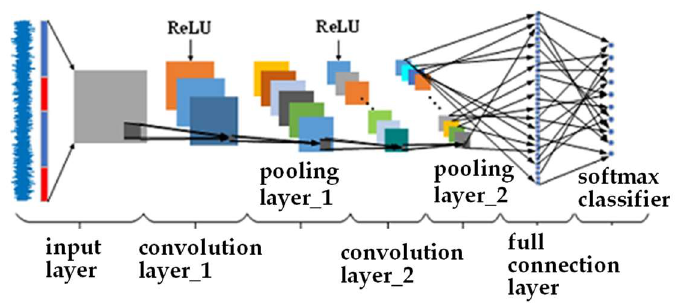
Figure 1. two-dimensional convolutional neural network model. The specific parameters of the TDCNN structure are shown in Table 1. The initial learning rate is 0.01, the momentum value is 0.9, the offset is 0, the number of